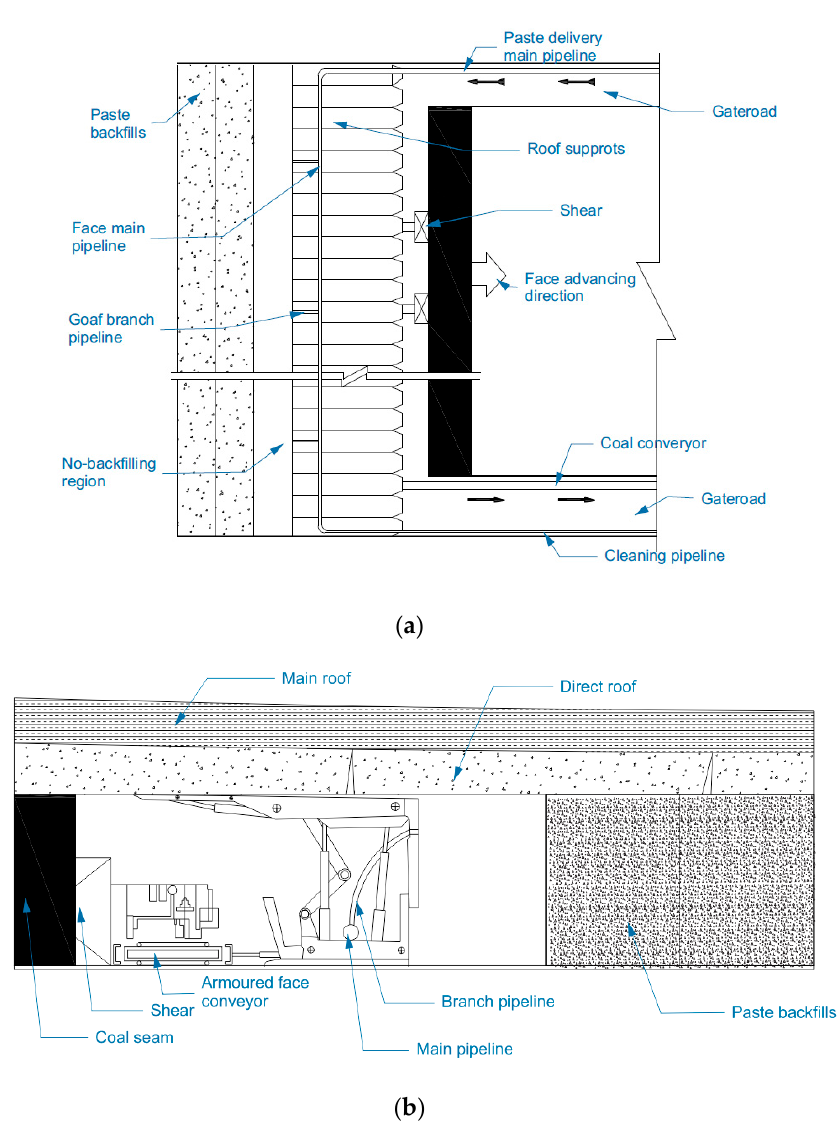
Figure 12. Schematic diagram of longwall mining. ( a ) Backfilling panel layout plan; ( b ) Cross section graph.